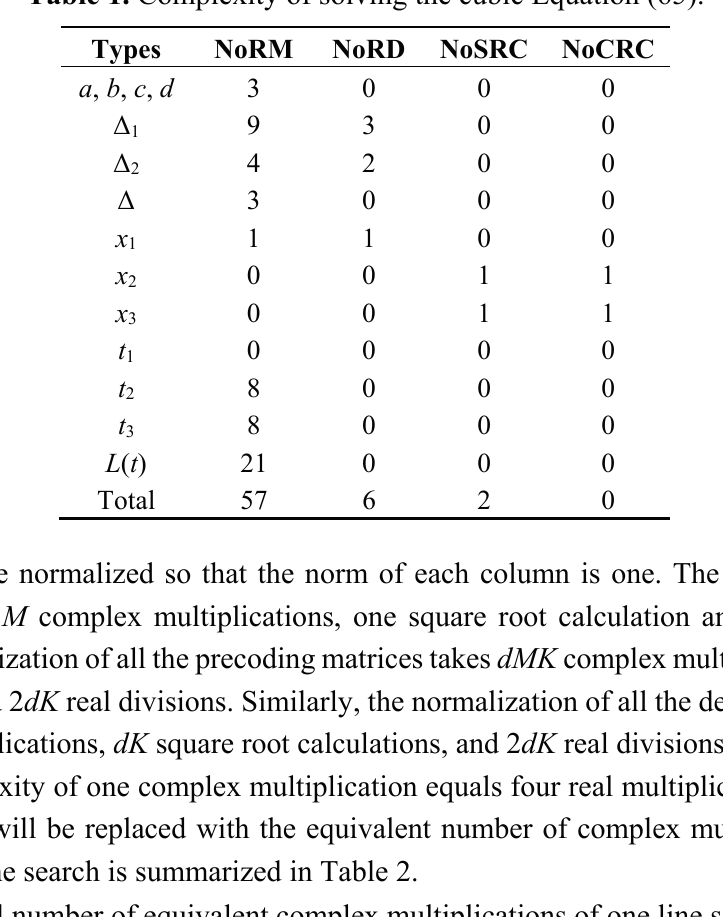
Table 1. Complexity of solving the cubic Equation